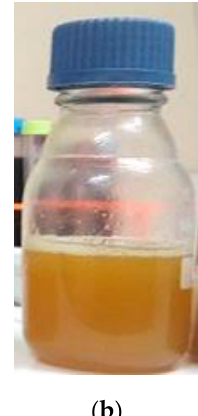
Table 1. Physicochemical properties of apple fresh juice and cryoconcentrated samples at each cycle 1 .